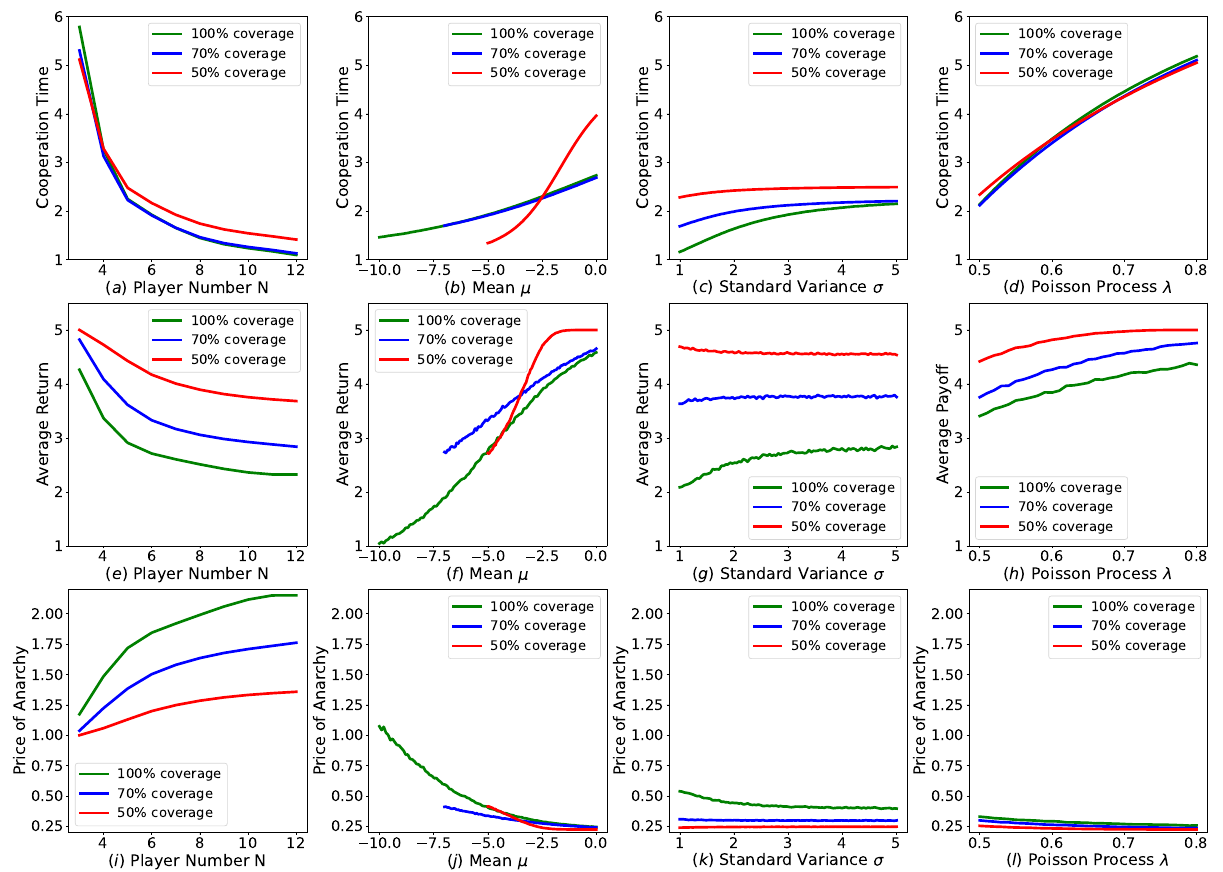
Figure 4. Performances of equilibrium plan in revision public goods game with various player number and deadline uncertainty settings. For each column, we change player number N , µ , σ of normal deadline distribution and Poisson process λ , to check how these parameters cause effects on the players’ behavior and payoff in each